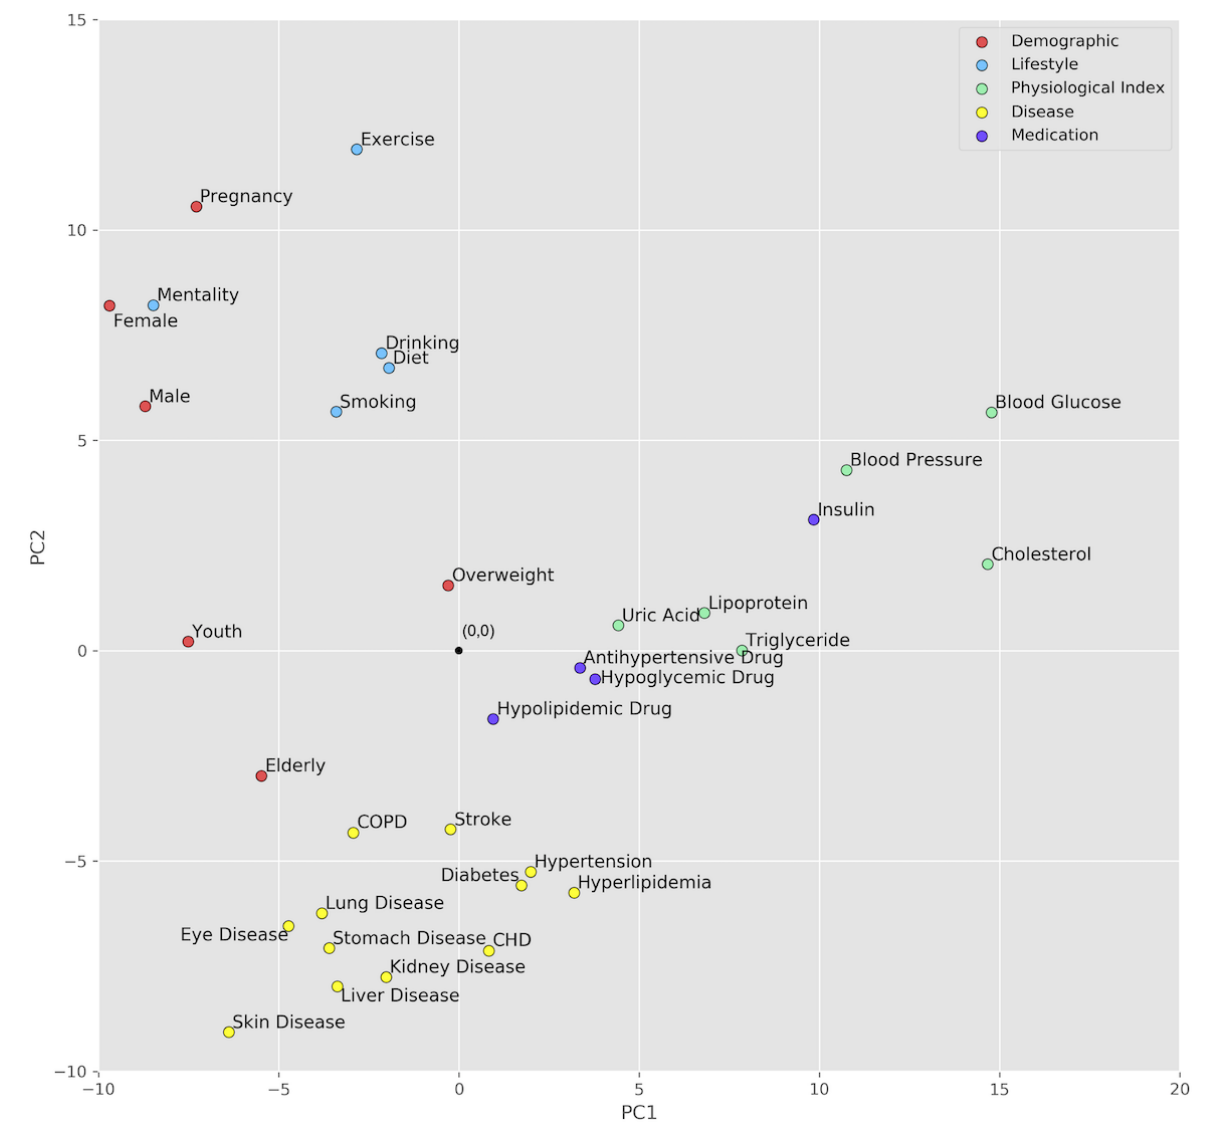
Figure 10. Word2Vec embedding visualization of the 33 ontology vector